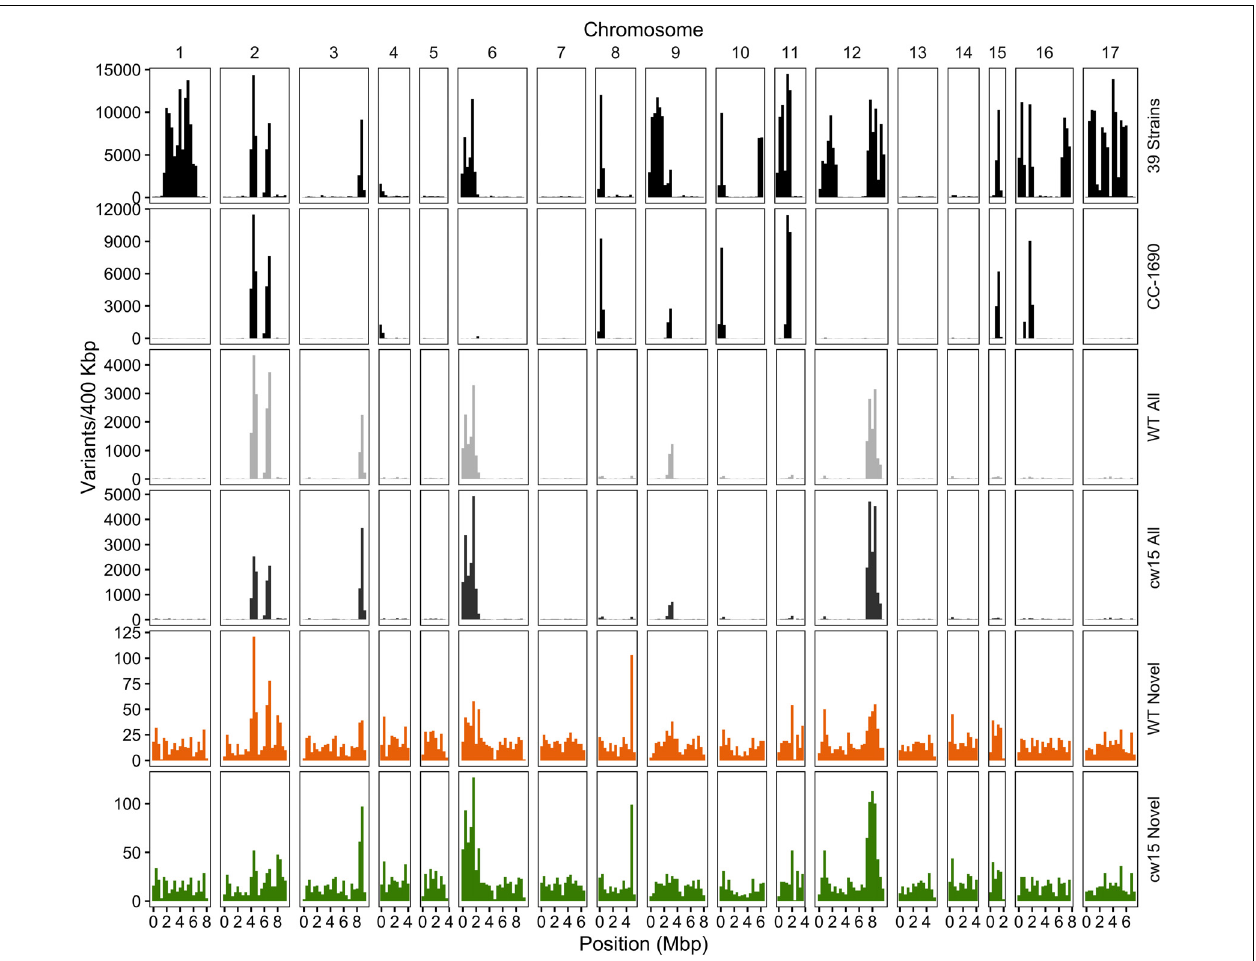
FIGURE 5 | Density of SNP and indel variants in the Chlamydomonas genome. The Y -axis is the number of variants per 400 kb, and the X -axis is the physical distance of each chromosome. The variant dataset plotted is labeled on the right of each panel. Variants from 39 laboratory strains (black, top panel) and CC-1690 (black, second panel) sequenced by Gallaher et al. (2015). Light and dark gray show all high quality variants (step 4 in Figure 4 ) in the WT and cw15 strains. Orange (WT) and green ( cw15 ) plot novel variants after filtering identical matches to polymorphisms in the Gallaher et al. (2015) study (step 5 in Figure 4